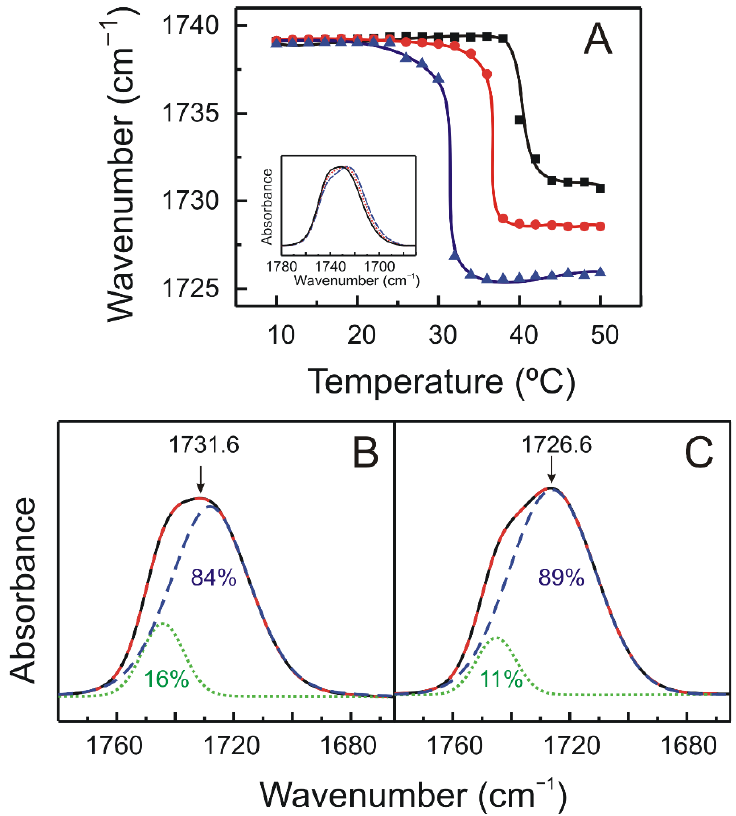
Figure 6. ( A ) Temperature dependence of the maximum of the ester carbonyl stretching band, ν (C=O), exhibited by pure DMPS (squares) and DMPS containing TMBC at 0.07 (circles) and 0.20 (triangles) molar fractions. The inset shows the 1780–1670 cm − 1 spectral region containing the absorption band originating from the ester carbonyl stretching band of pure DMPS (solid line) and DMPS containing TMBC at 0.07 (dotted line) and 0.20 (dashed line) molar fractions, at 45 ◦ C. FTIR spectra illustrating the components of the ester carbonyl stretching band, exhibited by ( B ) pure DMPS and ( C ) DMPS containing TMBC at 0.20 molar fraction at 45 ◦ C. The different lines represent: solid line, observed baseline corrected spectra; large dashed line, fitted spectra; dotted line, estimates of the component band appearing at 1742 cm − 1 ; and short dashed line, estimates of the component band appearing at 1728 cm − 1 , as determined by the curve fitting. The arrows point to the maximum of the ester carbonyl stretching